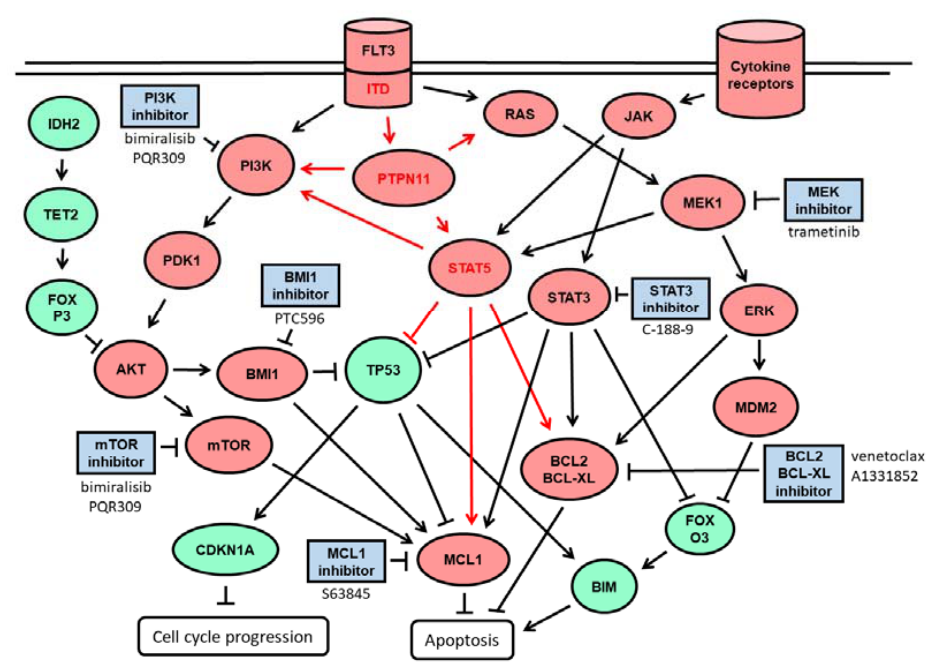
Figure 1. Schematic representation of signaling pathways in myeloid cells. The inducible growth factor receptor FLT3 signals via PI3K ‐ AKT ‐ mTOR and RAS ‐ MEK ‐ ERK (black arrows). FLT3 ‐ ITD, a constitutively active growth factor receptor, additionally induces PTPN11 ‐ STAT5 (red arrows). Activated cytokine receptors signal via Janus kinase (JAK) ‐ signal transducer and activator of transcription (STAT) pathway. Signal transduction leads to inhibition of the tumor suppressor p53 and induction of the anti ‐ apoptotic BH3 proteins BCL2, BCL ‐ XL, and MCL1, thereby promoting proliferation and cell growth of myeloid cells. Oncogenic functions are indicated in red, tumor suppressor functions in green, chemical inhibitors in blue.